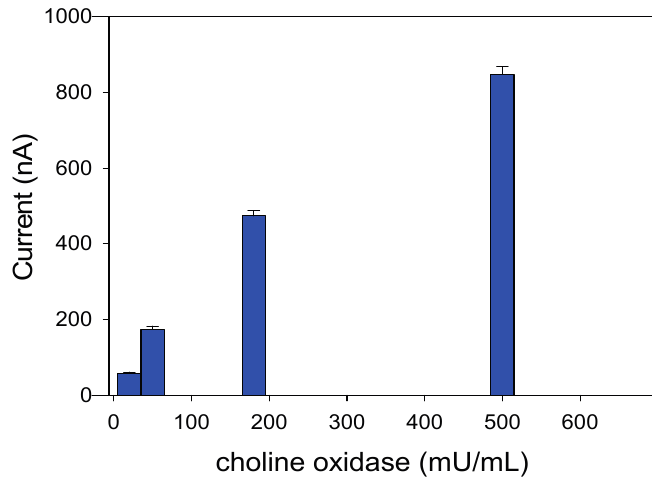
Figure 2. Bioassay response by varying the amount of choline oxidase. Choline at final concentration of 0.5 mM, applied potential: − 50 mV vs. Ag/AgCl, 0.05 M phosphate buffer + 0.1 M KCl, pH 7.4. Measurements were carried out in triplicate.